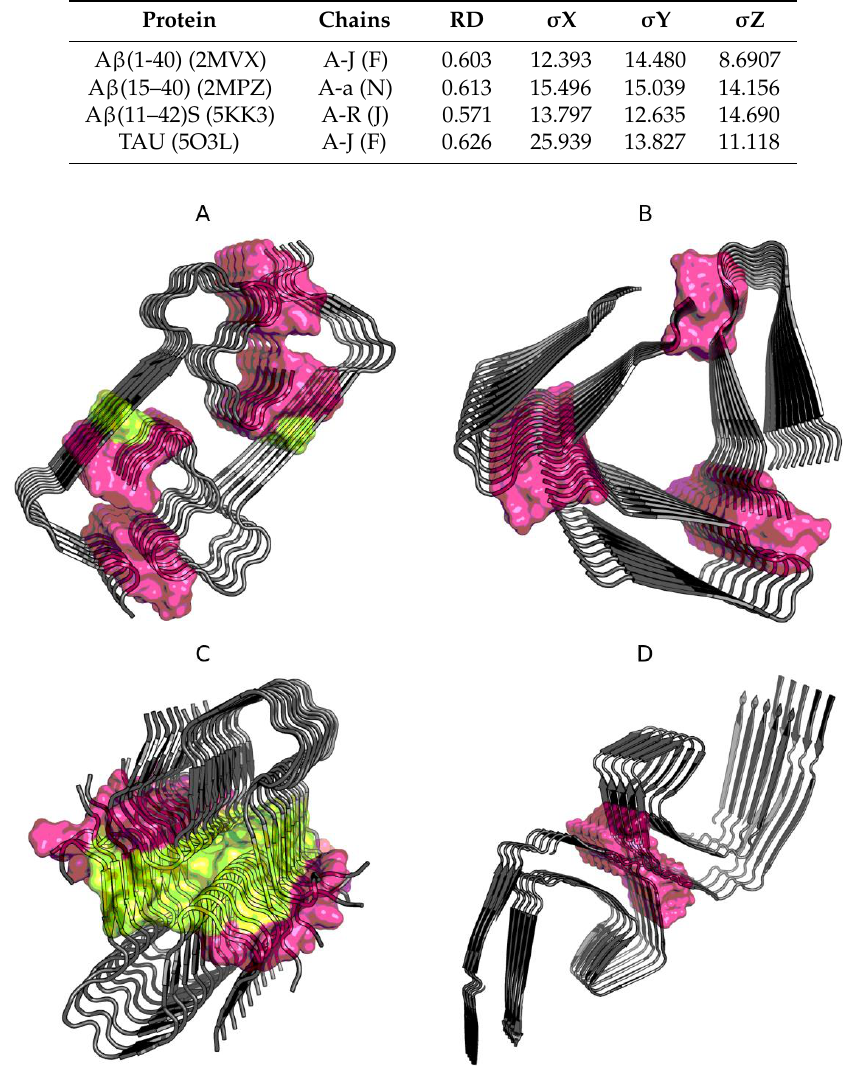
Figure 1. Location of interface residues in A β (1–40) (2MVX— A ), A β (15–40) (2MPZ— B ), A β (11–42)S (5KK3— C ), and TAU (5O3L— D ). Residues are distinguished according to Table 2: interface is shown as surface, with noncompliant residues in yellow (on A and C